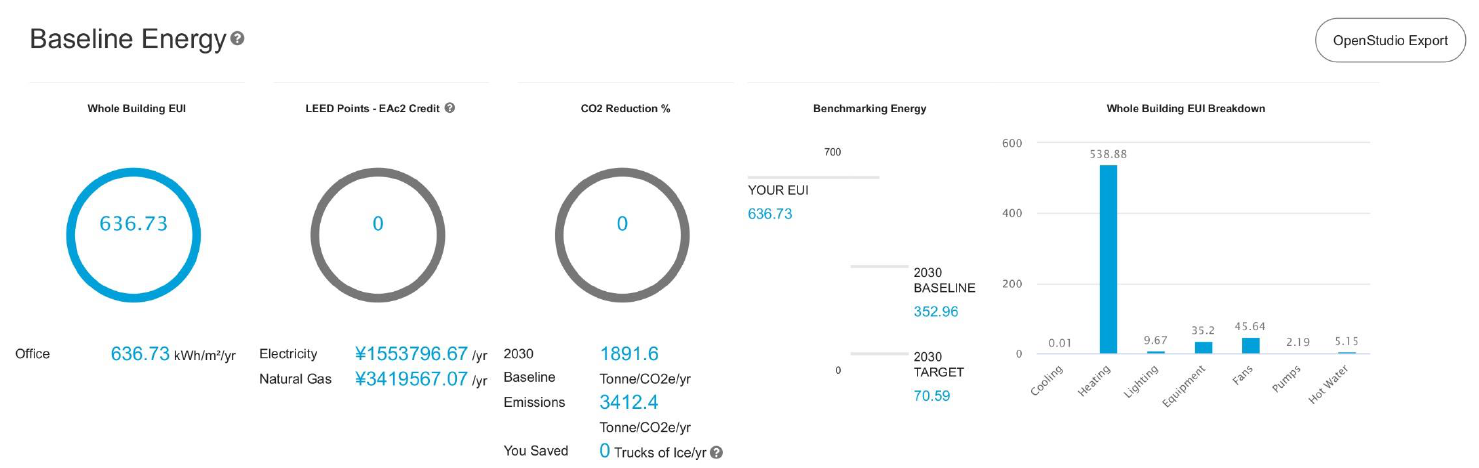
Clean Technol. 2022 , 4 , FOR PEER REVIEW Figure A45. Zone 7-H Delingh á , Qinghai (post-COVID-19 84% scenario). Figure A45. Zone 7-H Delinghá, Qinghai (post-COVID-19 84% scenario).